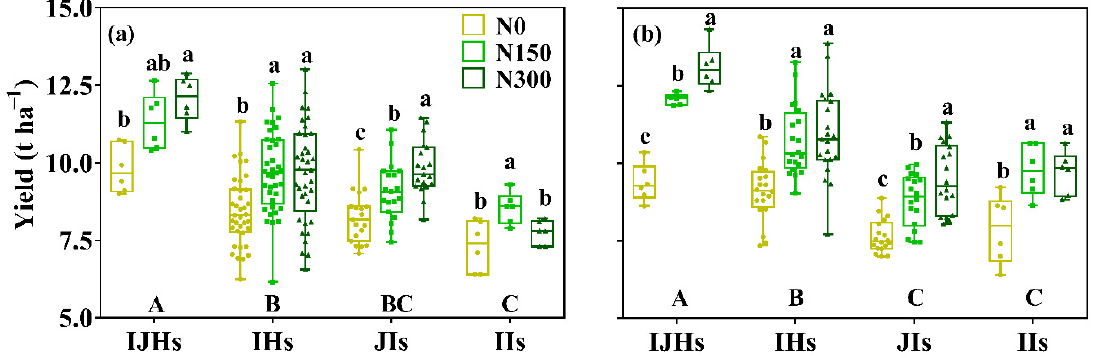
Figure 2. Boxplots of yield for indica-japonica hybrids (IJHs), indica hybrids (IHs), japonica inbreds (JIs), and indica inbreds (IIs) under different N levels in 2017 ( a ) and 2018 ( b ). Data are the means of three replicates. The horizontal lines in the boxes indicate median values in each treatment; the lower limits and upper limits of the boxes represent the 25 and 75 percentiles, respectively; and vertical bars of the boxes represent the 5 and 95 percentiles; different color boxes indicate different N treatments. Different uppercase letters above the columns indicate statistical significance at the p < 0.05 level among different rice groups, and different lowercase letters above columns indicate statistical significance at the p < 0.05 level among different nitrogen levels.